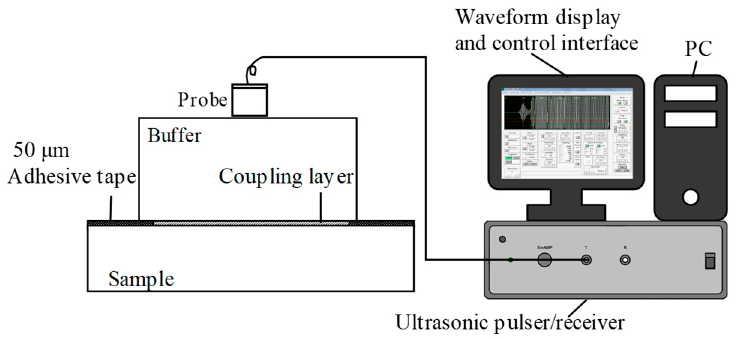
Figure 8. Schematic diagram of the experimental setup.